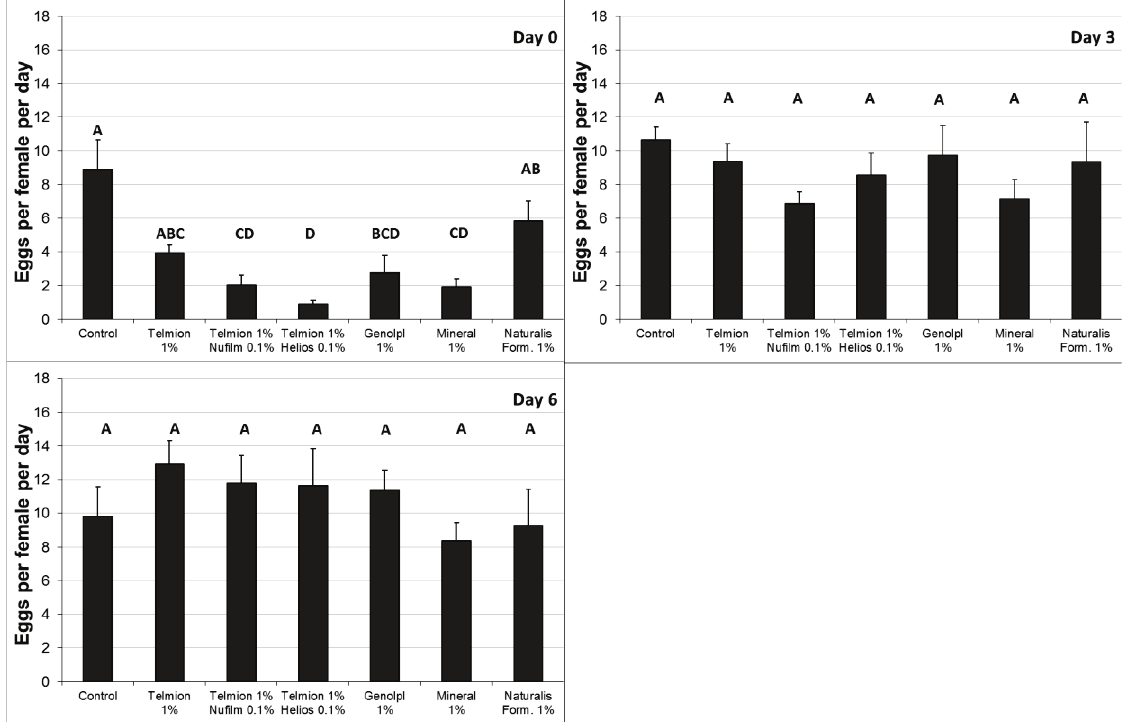
Figure 3. Second semi-field experiment: Number of eggs per female per day (±se) in fruit samples exposed for oviposition immediately (0 day), 3 and 6 day after treatment. Different letters show significant differences (one- way ANOVA, Tukey HSD, α =